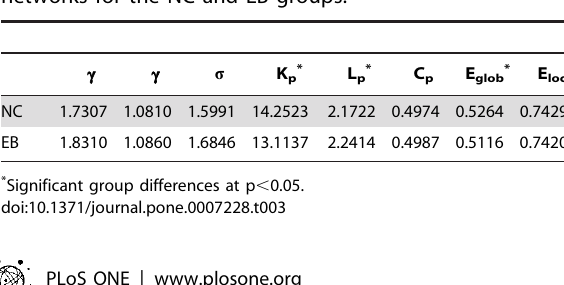
Table 3. The mean values of the topological properties of the networks for the NC and EB